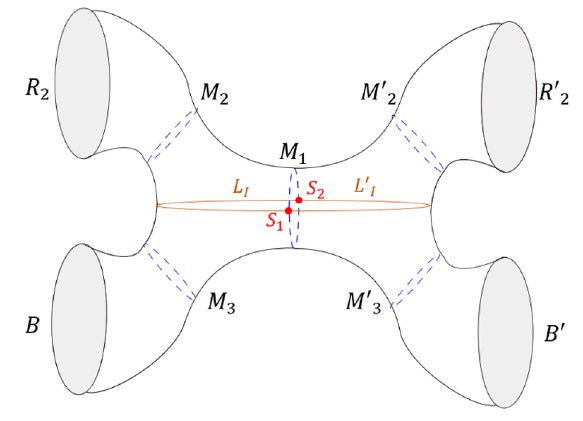
Figure 4 . The purification is similar to figure 2. The only different point is that here we remove the entanglement wedge of R 1 and purify R 2 and B . Note that the reflected entropy between R 2 and B corresponds to twice the length of the minimal geodesic of M 2 , L I and M 3 .